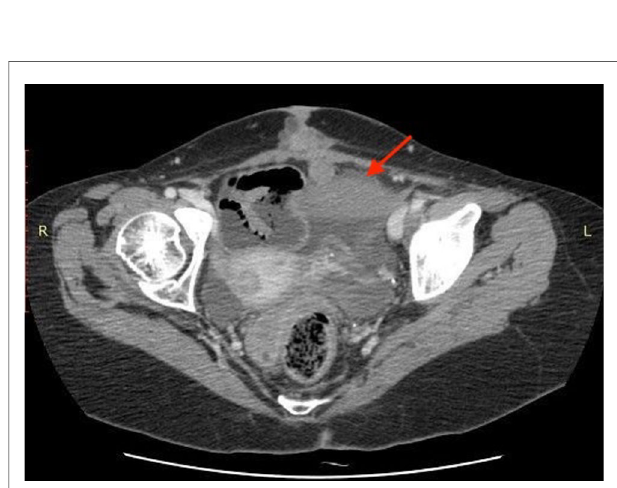
FIGURE 2 | Increased spleen size, caudalized and with reduced enhancement after MDC. Noted also intra-abdominal over fl ow.